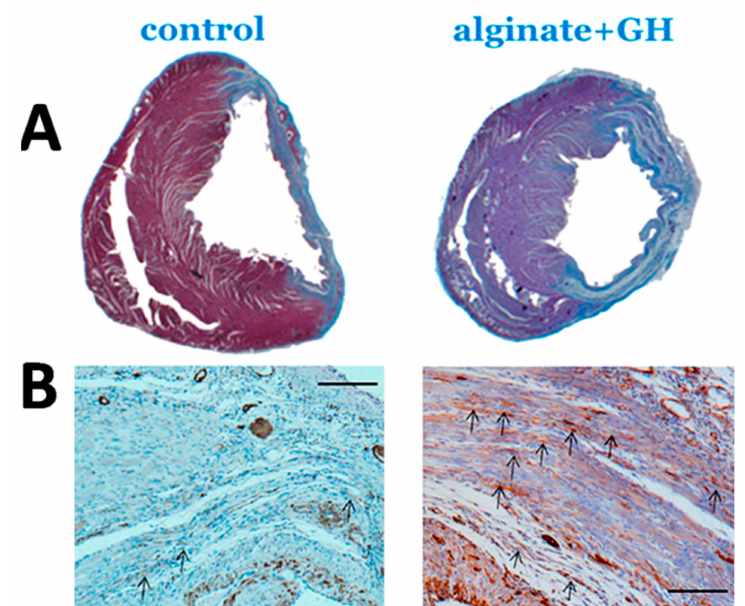
Figure 4. Structural remodeling. ( A ) Infarct thickness (Heidenhain’s AZAN-trichrome staining, scale: 500 mm) was preserved after treatment with growth hormone (GH), administered via an alginate sca ff old. ( B ) Myofibroblast density in the peri-infarct-area ( α -smooth-muscle-actin staining, arrows, scale: 50 mm) was higher after treatment. Adapted from Daskalopoulos et al., Growth Factors 33 (2015) 250–258 [37], with